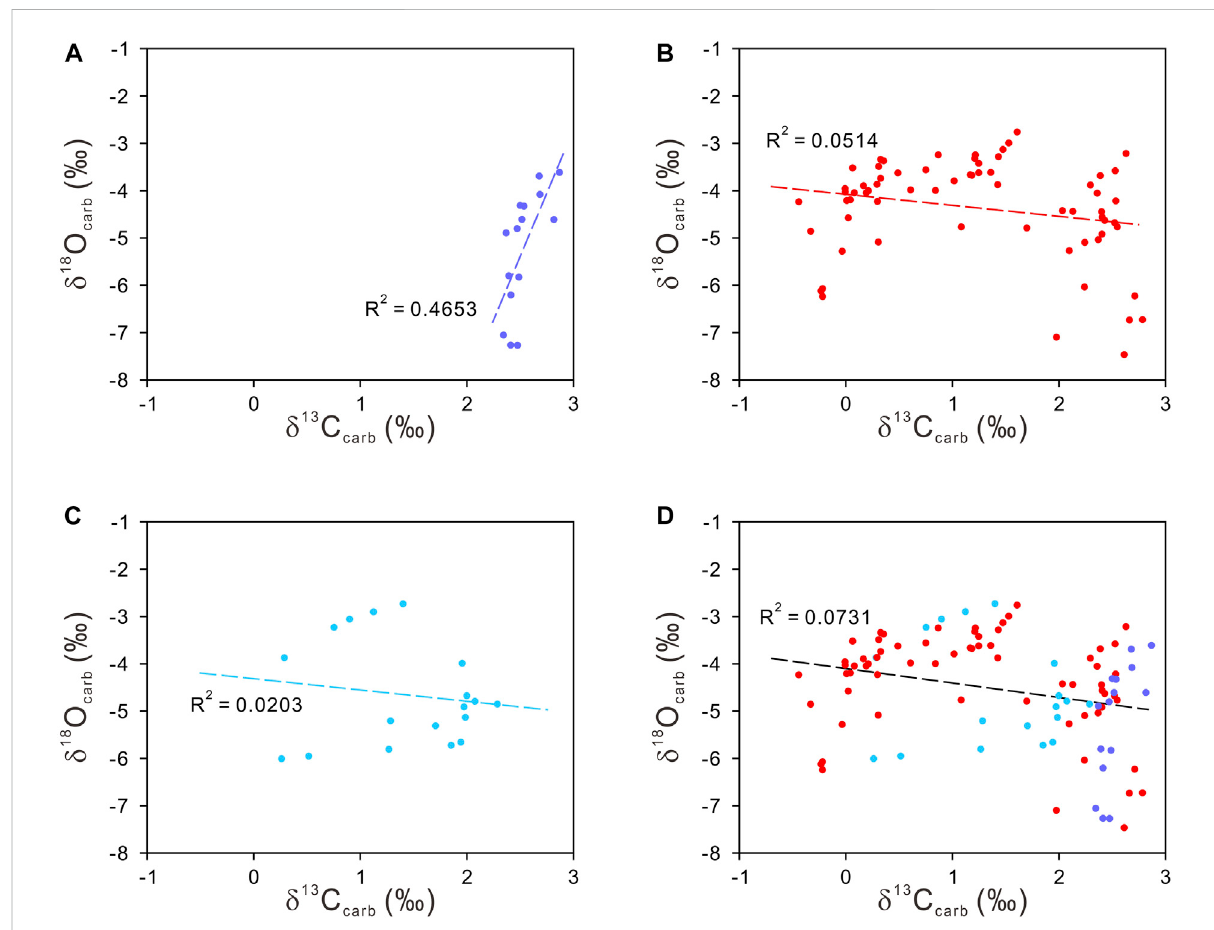
Cross-plot of δ 13 C carb and δ 18 O carb for pre-extinction skeletal limestone (A) , microbialites (B) , overlying grainstones and packstones (C) , and all samples from the Dajiang section (D)